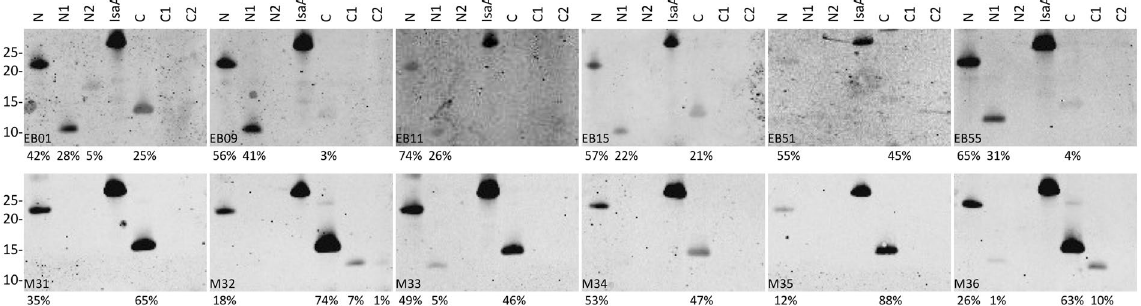
Figure 6. Differential binding of human and murine IgGs to IsaA-derived fragments. Proteins in the growth medium fractions of L . lactis PA1001 producing the full-size IsaA or N-terminal (N, N1, N2) or C-terminal (C, C1, C2) fragments of IsaA were separated by LDS-PAGE. Next, a Western blotting analysis was performed using sera from EB patients (EB01, EB09, EB11, EB15, EB51 and EB55) or sera from the mice immunized with IsaA (M31, M32, M33, M34, M35 and M36). The molecular weights (kDa) of marker proteins are indicated on the left. The intensities of detected bands were assessed with ImageJ, and the relative intensity for each band is indicated below each blot as the percentage of the total intensity determined for full-size IsaA plus the N-terminal (N, N1, N2) and C-terminal (C, C1, C2)